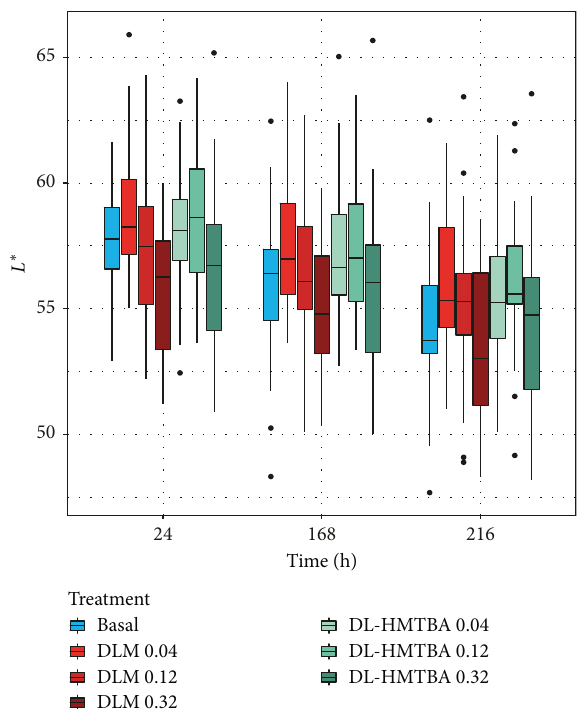
Figure 2: L values of breast fillets during storage ( n ∗ (Table 2). The microbial acceptance level of Pseudomonas